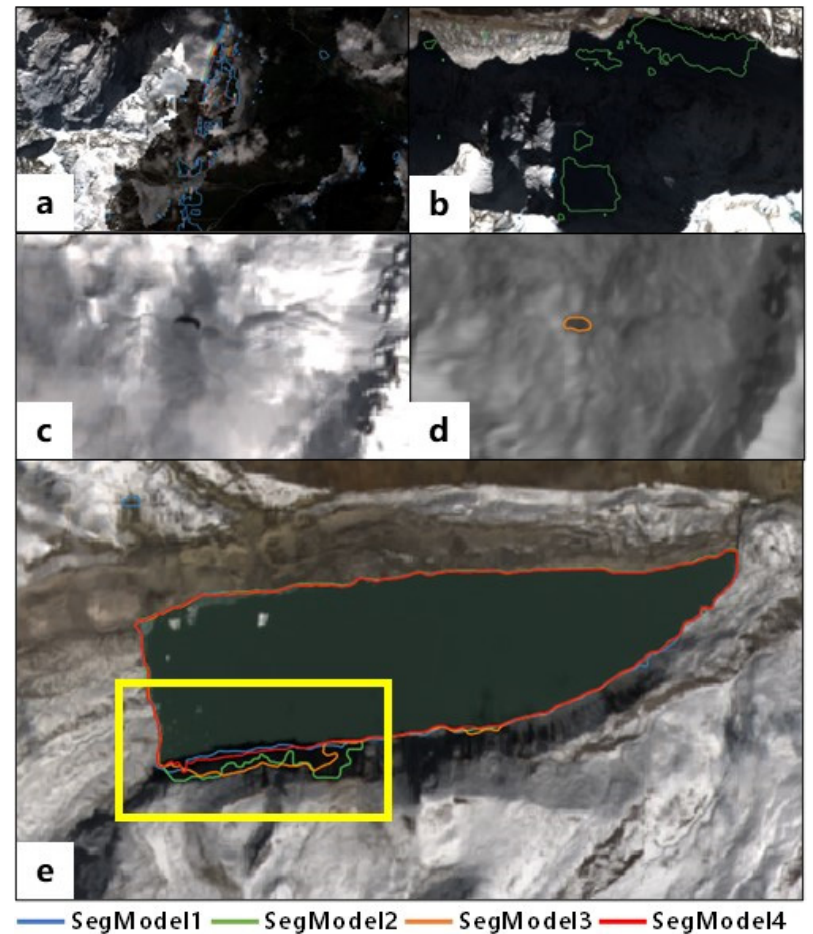
Figure 9. Advantages and problems in different scenarios: ( a ) False positives caused by using only true color images. ( b ) False positives extracted by MNDWI due to shadows. ( c ) A lake covered in clouds ( d ) was extracted after the addition of VV. ( e ) Shadow removal after adding Relief data.